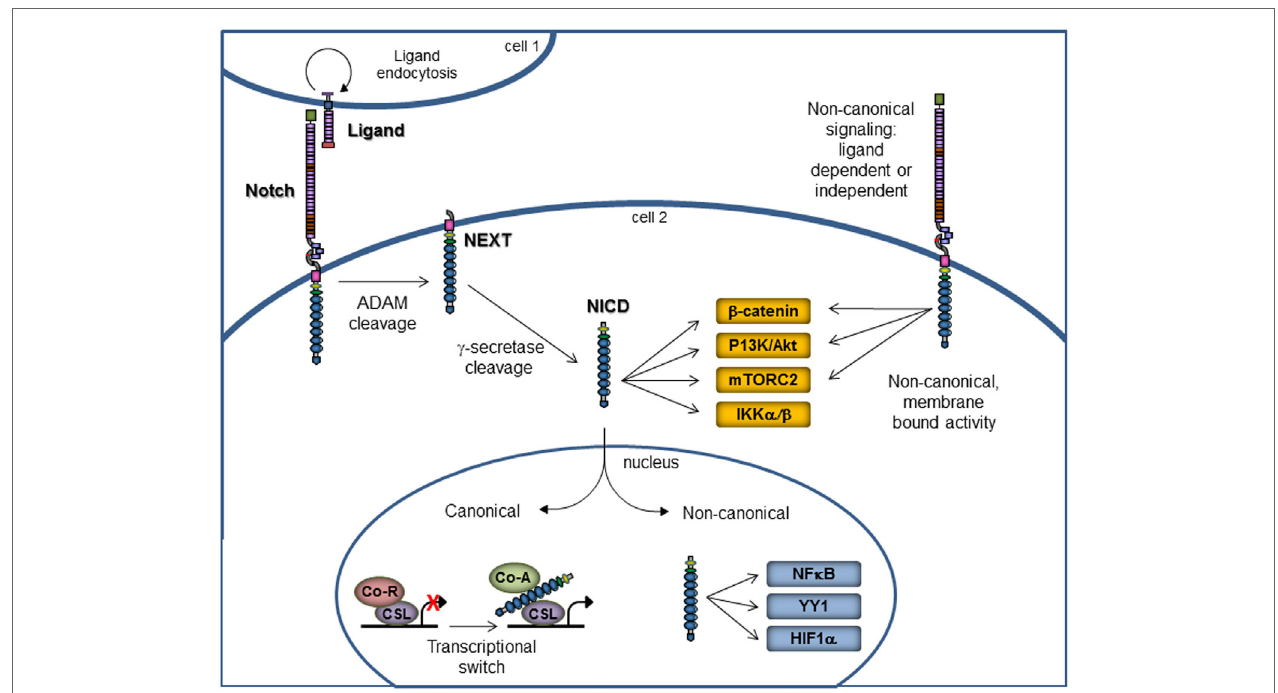
FiGURe 1 | Notch canonical and non-canonical signaling . Notch signaling via the canonical pathway is on the left portion of the figure. Membrane-bound Notch receptor is activated by binding with ligand on a neighboring cell, which results in cleavage by ADAM metalloproteases, followed by cleavage with γ -secretase. These cleavage events release the NICD, which then enters the nucleus to affect the gene transcription. The non-canonical signaling pathway is on the right portion of the figure and illustrates that non-canonical signaling may occur either in the presence or absence of ligand. Further, the signaling may occur via the membrane-bound, uncleaved Notch receptor or via the NICD. Non-canonical Notch signaling is independent of CSL and allows for interaction with PI3K/AKT/ mTORC2, Wnt/ β -catenin, IKK α / β , NF κ B, YY1, and HIF1 α pathways at the cytoplasmic and/or nuclear level. Abbreviations: ADAM, a disintegrin and metalloprotease; NEXT, Notch extracellular truncation; NICD, Notch intracellular domain; Co-R, corepressor; Co-A,